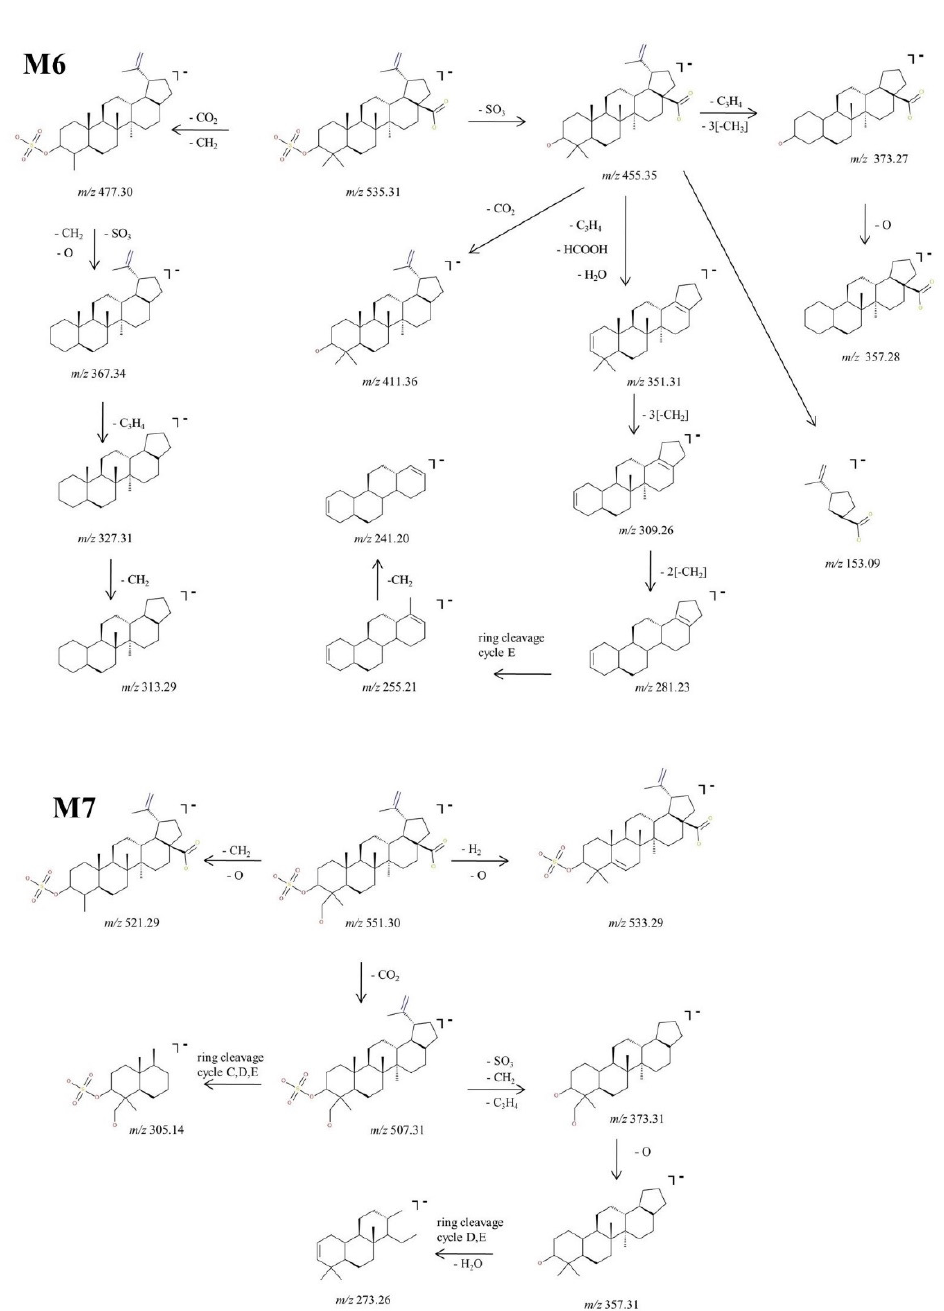
Figure 6. ESI CID MS/MS spectra in the negative ion mode of phase II metabolites detected as [M − H] − ions:: M5 ( m / z 469.37), M6 ( m / z 535.31), M7 ( m / z 551.30), M8 ( m / z 565.28), M9 ( m / z 567.30), M10 ( m / z 631.39),M11 ( m / z 647.38), M12 ( m / z 661.36) and M13 ( m / z 663.37); spray voltage 0.70 kV, capillary temperature 275 °C and collision energies within 0–35 eV.